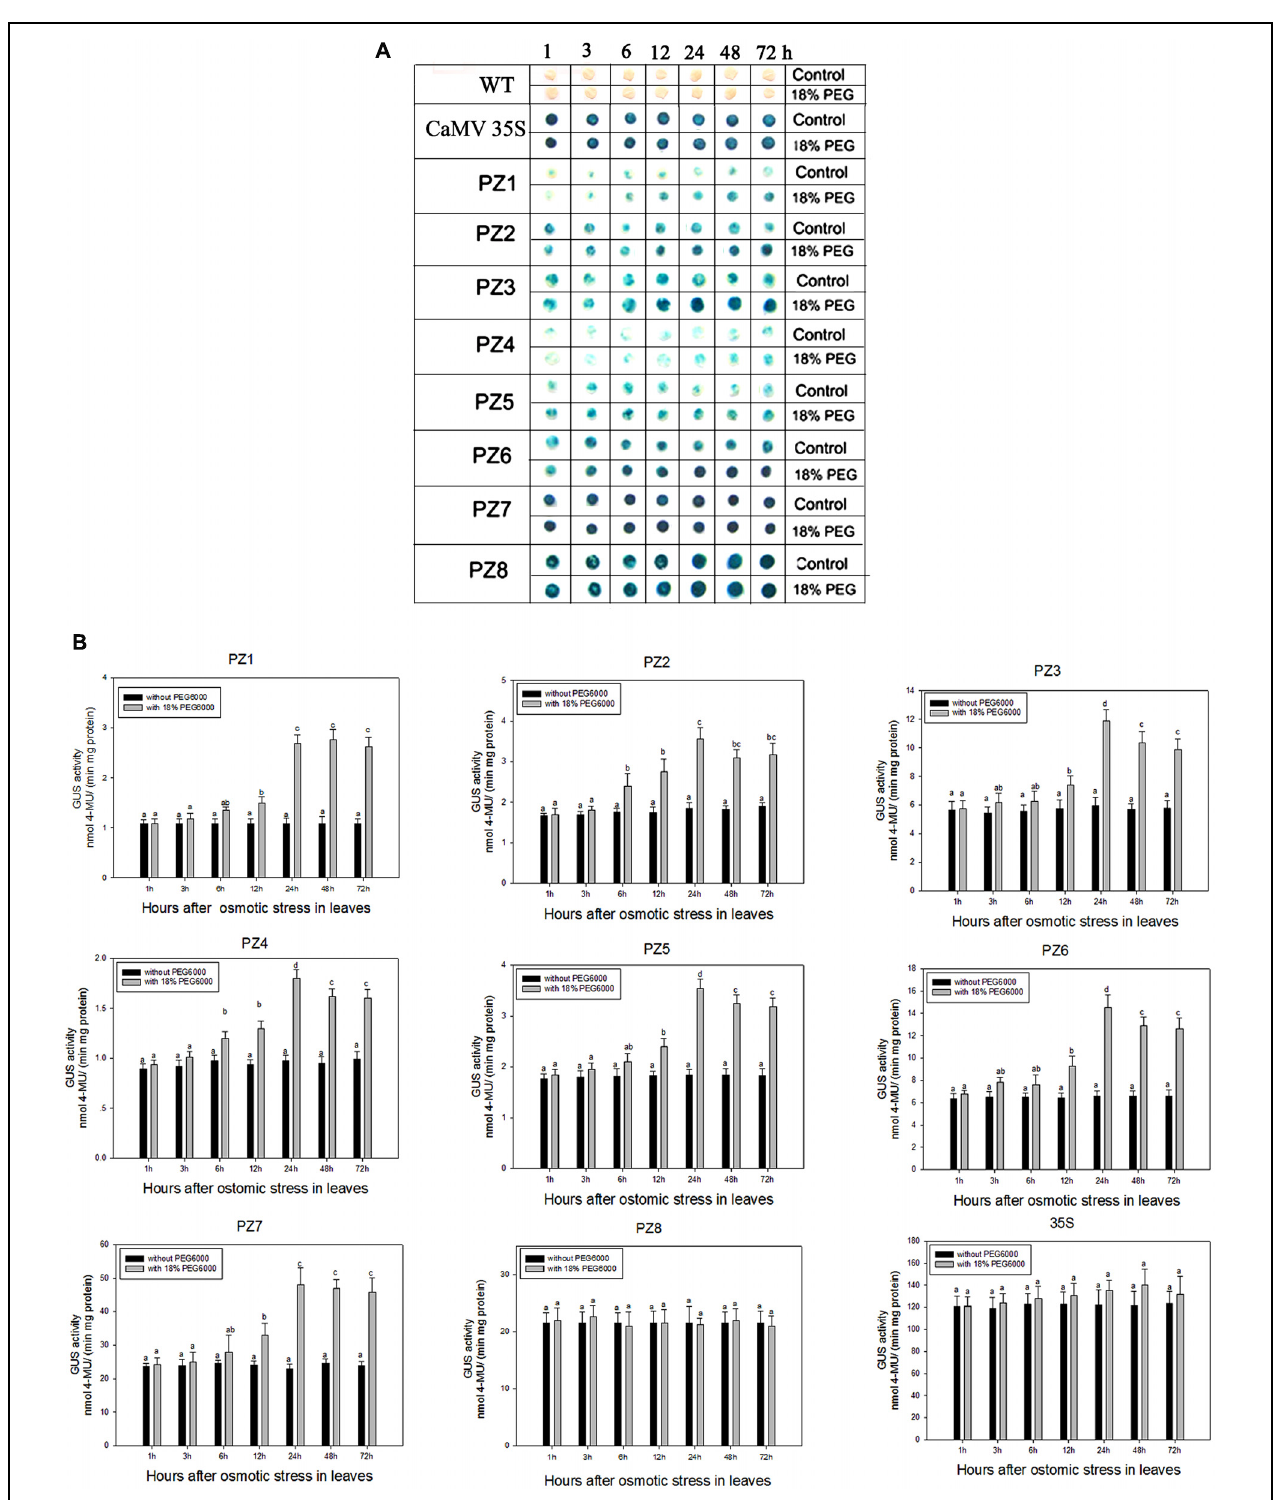
FIGURE 6 | GUS histochemical staining and fluorescent quantitative analysis of transgenic tobacco expressing eight truncated promoter of pZmPIS::GUS under normal and osmotic stress conditions. (A) GUS histochemical staining. (B) GUS fluorescent quantitative analysis. The tobacco plants were incubated in the liquid 1/2 MS medium supplemented with 18% (w/v) PEG 6000 for 1, 3, 6, 12, 24, 48, and 72 h. The plants grown in the liquid 1/2 MS medium were treated as control. Values represent the mean ± standard deviation from three independent transgenic lines and each line five individual plants for each construct. Different lowercase letters above the bars indicate significant differences at P <